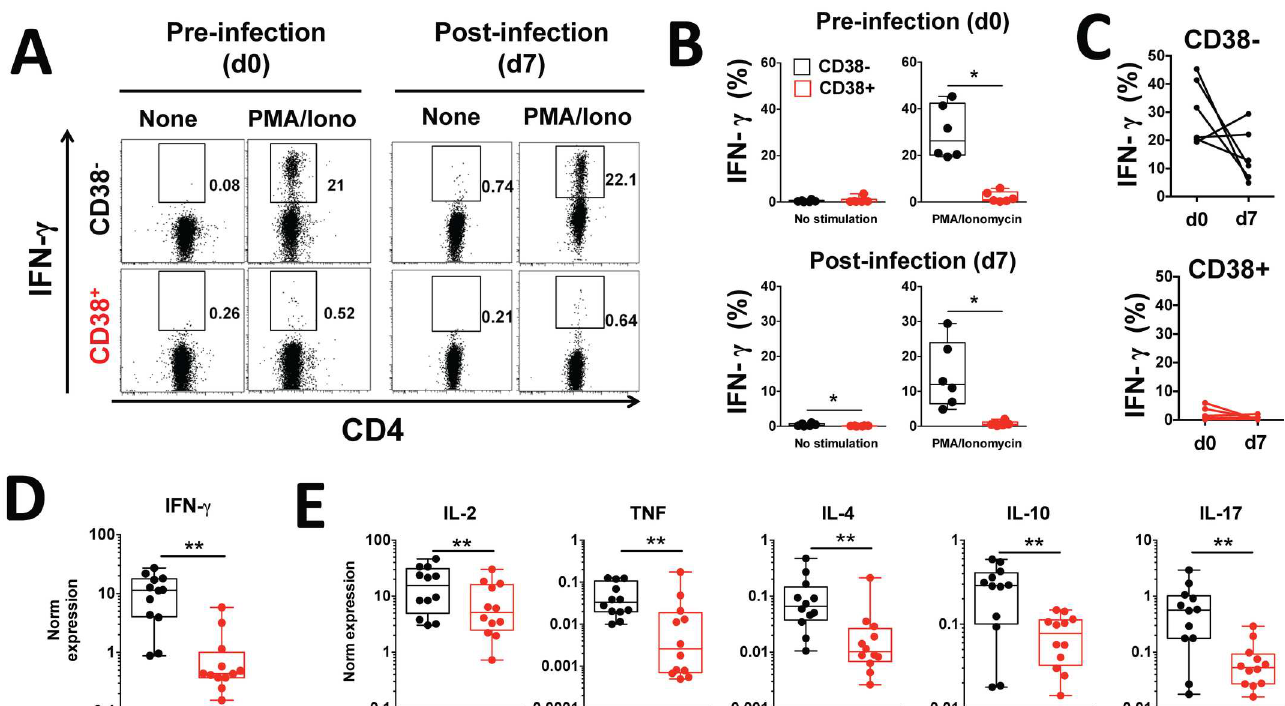
Fig 5. CD38 + CD4 + T cellsare poorproducers of IFN- γ following in vitro stimulation.(A-C) Peripheral blood was collectedpriorto and seven days post-infectionand CD38 - (black) and CD38 + (red)CD4 + T cells isolatedusing cell sorting.IntracellularIFN- γ productionafterbriefmitogenic stimulationwith PMA and Ionomycin was measuredat the proteinlevel using flow cytometry. (D-E) Peripheral blood was collectedfromhealthy uninfected volunteers and (D) IFN- γ and (E) IL-2,TNF, IL-4,IL-10and IL-17gene expression afterbriefmitogenicstimulationwith PMA and Ionomycinwas measuredby RT-qPCR. Gene expression was normalized to reference gene RPL13A.Graphs show combined data from(A-C)four to seven volunteers fromone cohortand (D-E)12 healthy volunteers; statisticaldifferences between CD38 + and CD38 - CD4 + T cells and between prior to and seven days post infection were determinedusing the non-parametricWilcoxon test;box and whisker plots indicatemedian,interquartilerange and min-max; * , p < 0.05, ** , p < 0.01; *** , p < 0.001; **** , p <